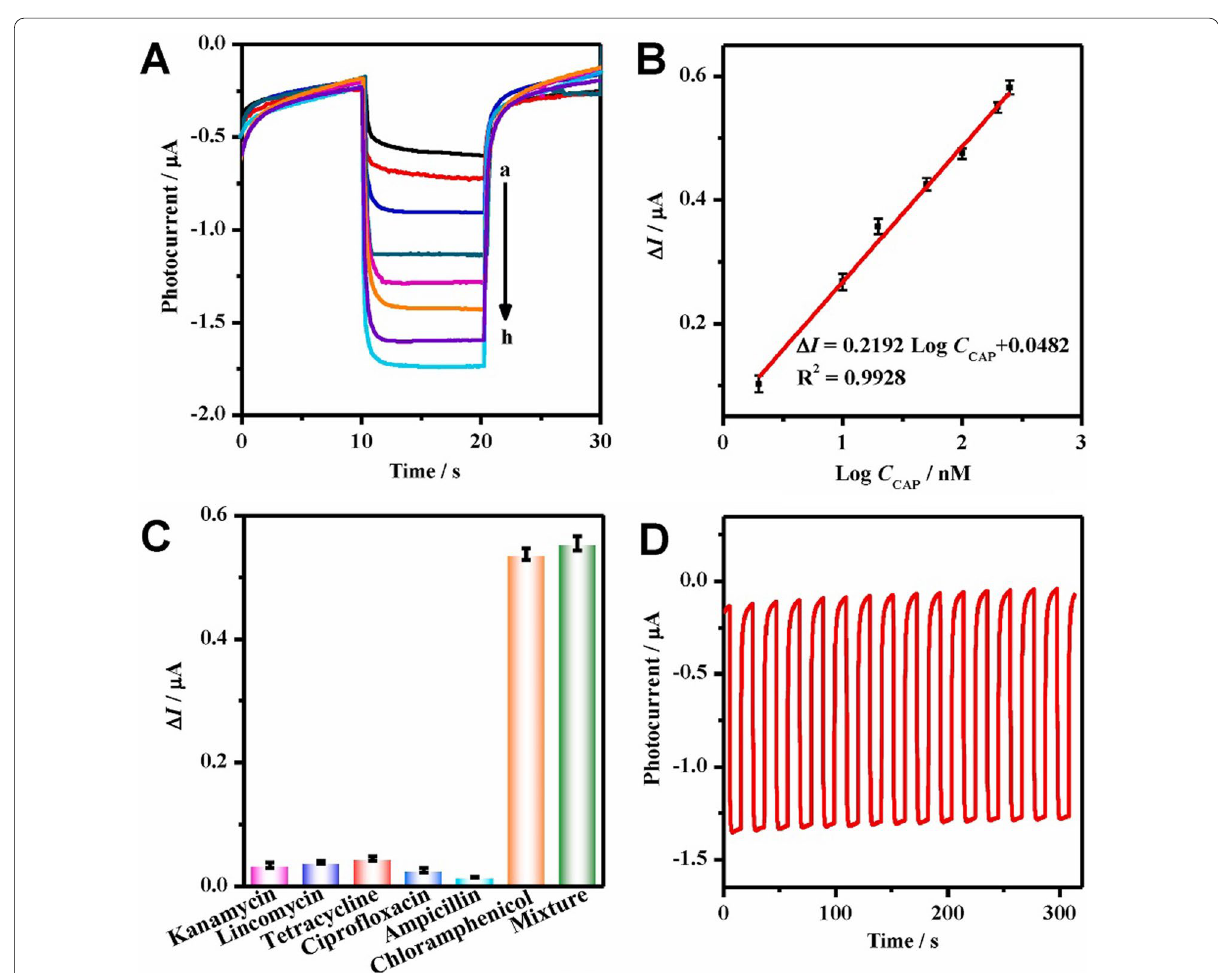
Fig. 16 Photocurrents A of the developed PEC aptasensor with different CAP concentrations (curves a–h: 0–250 nM). Calibration curve ( B ). Selectivity ( C ) toward 200 nM CAP with equal amount of the interfering substances (i.e., kanamycin, lincomycin, tetracycline, ciprofloxacin, and ampicillin), and their mixture. Stability ( D ) of the as-fabricated PEC aptasensor. Adapted from Ref. [140] with permission. Copyright (2021) Biosensors and